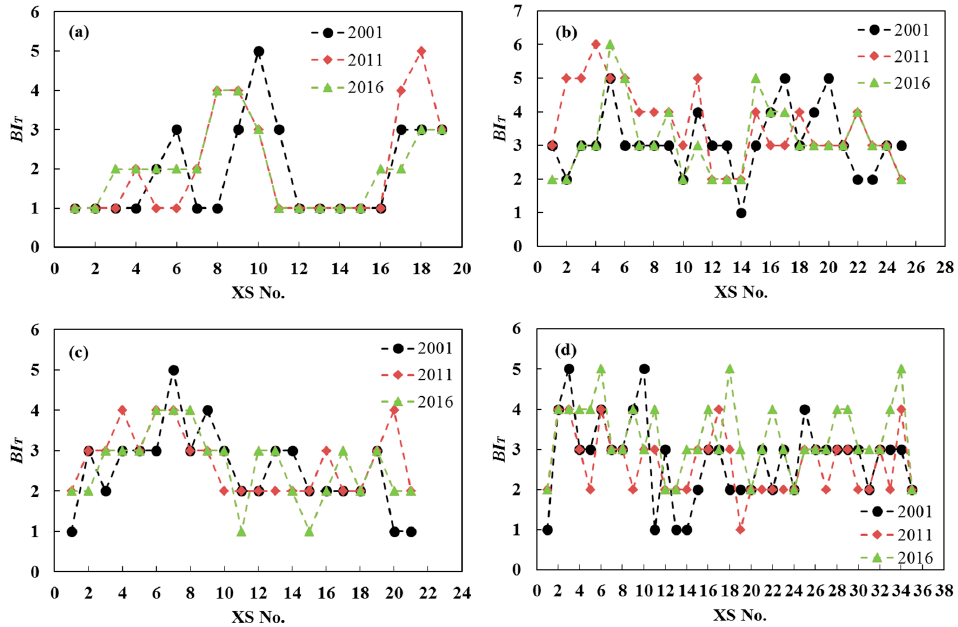
Figure 7. Changes of BI T values in four reaches along the channel ( a ) RS1; ( b ) RS2; ( c ) RS3; ( d ) RS4.